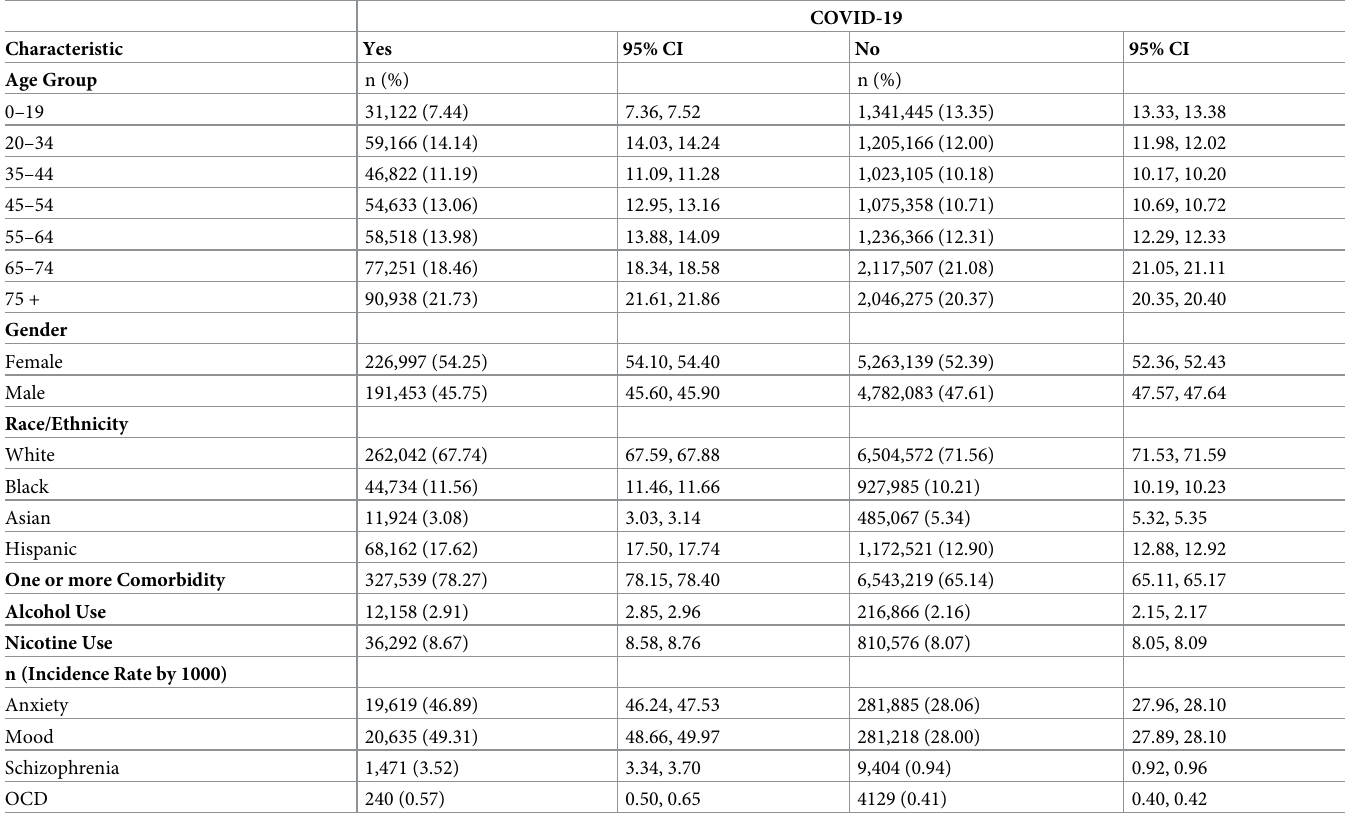
Table 2. Comparison of demographics and new psychiatric disorders between people with COVID-19 and those without COVID-19 in 2020.